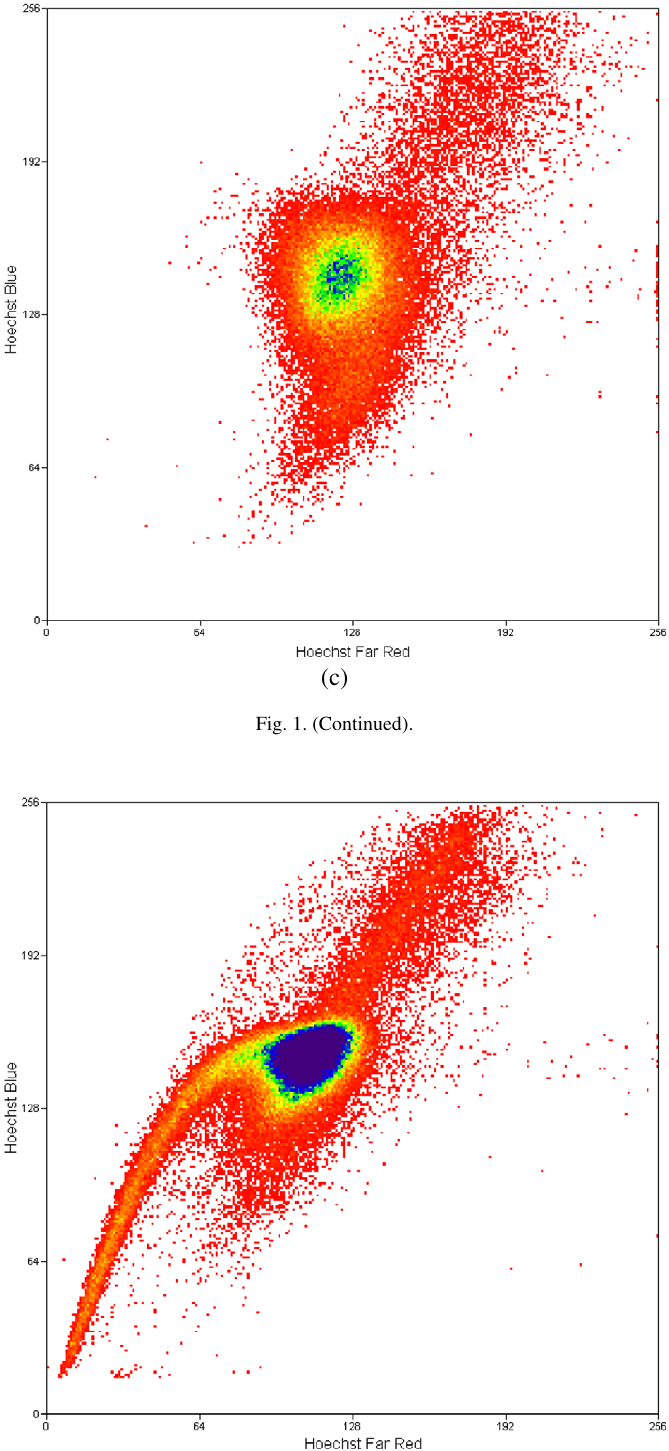
Fig. 2. Ho342 SP analysis of unpurified human bone marrow. The analysis was carried out using a filter setup consisting of BP 450/65 (blue), BP 670/40 (red) and 510 DLP filters which did not give the appropriate